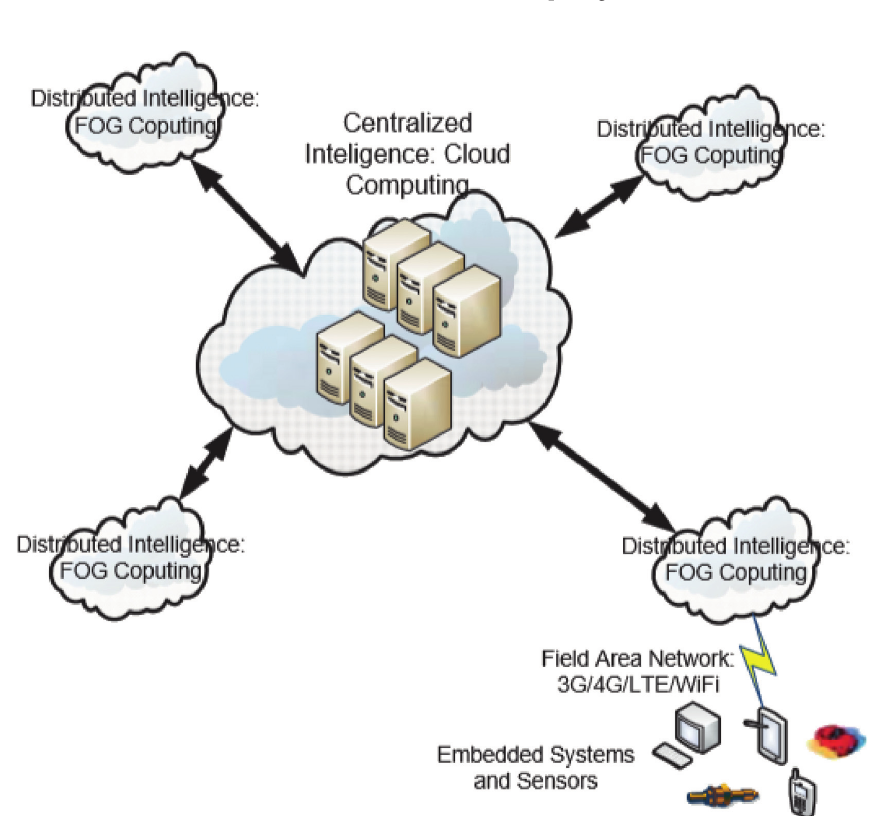
Figure 2: Structure of fog computing